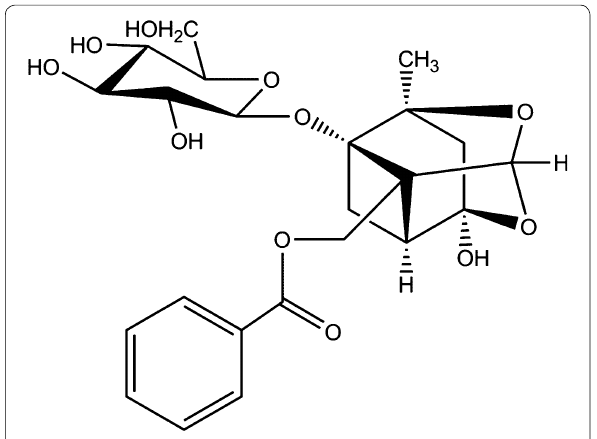
Fig. 1 The structure of